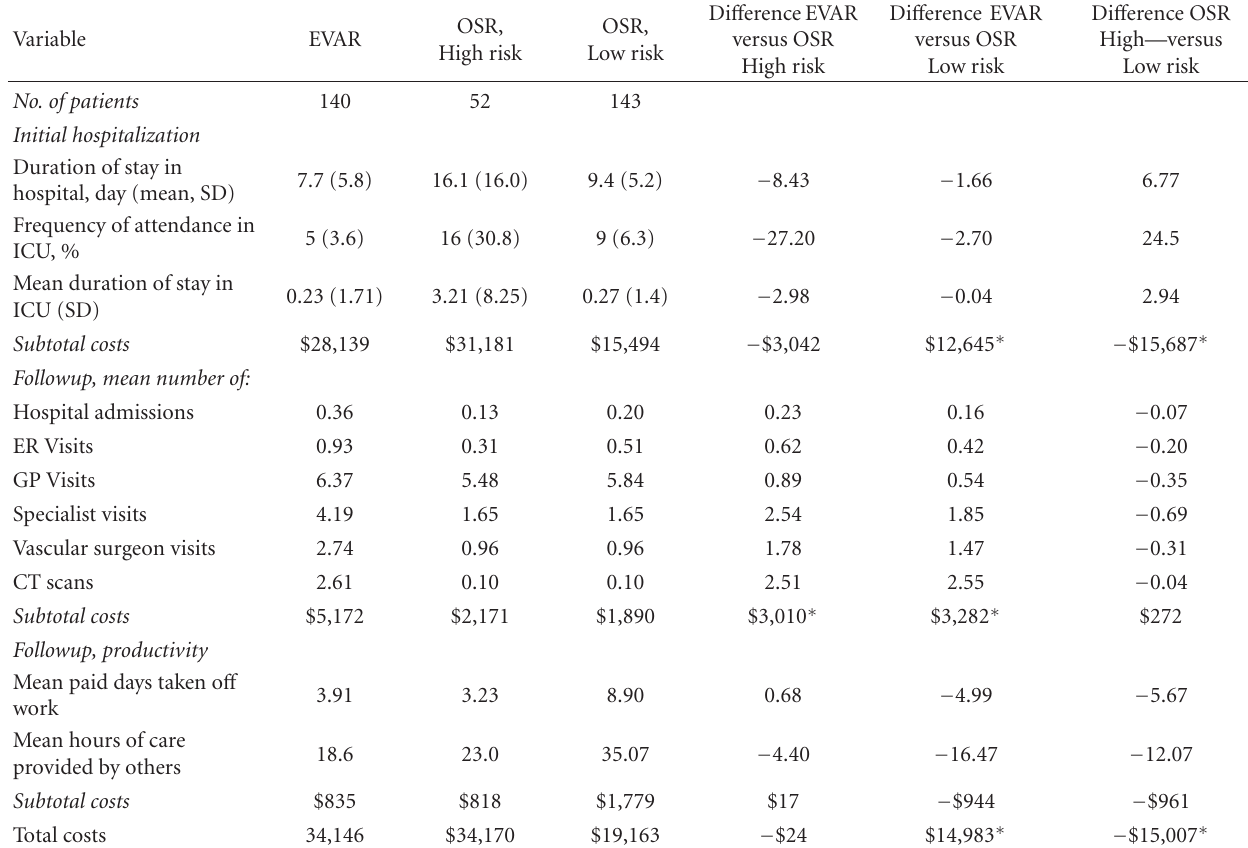
Table 3: One-year resource utilization and